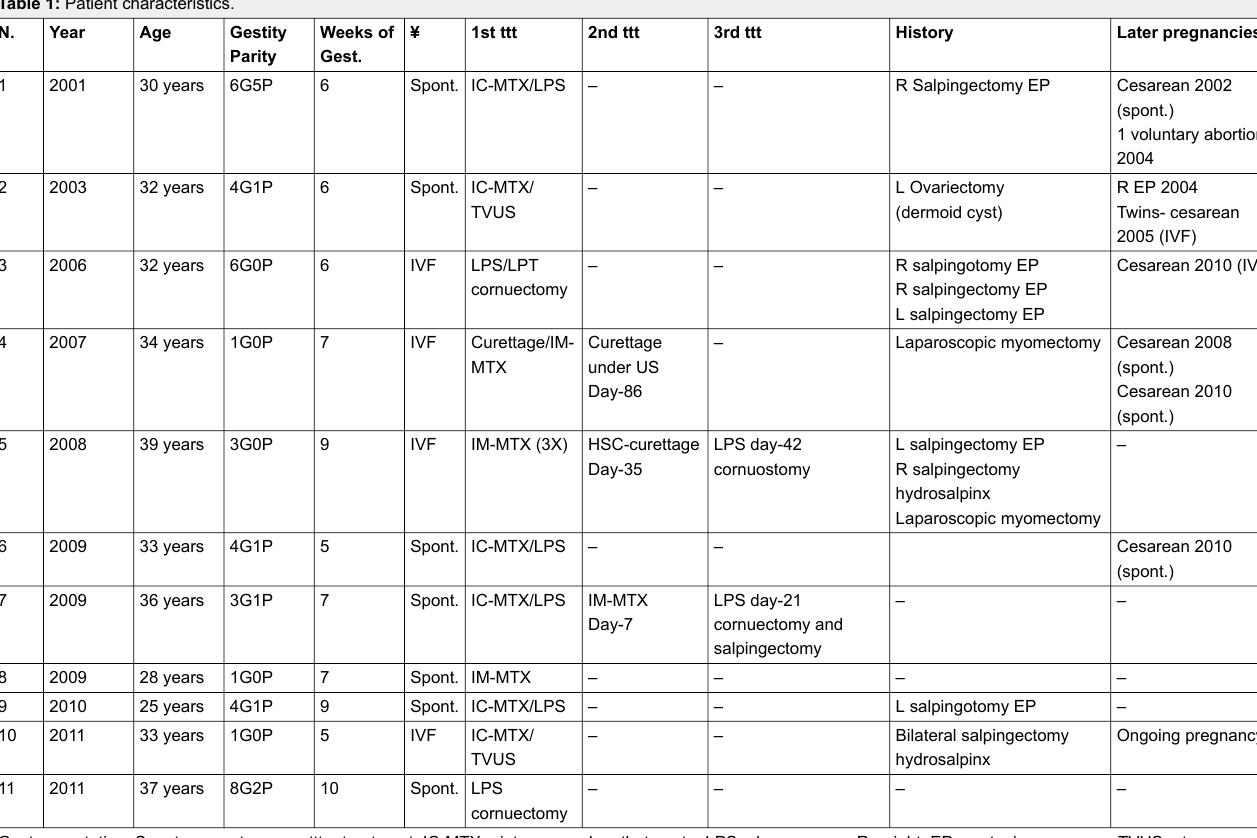
Table 1: Patient characteristics.